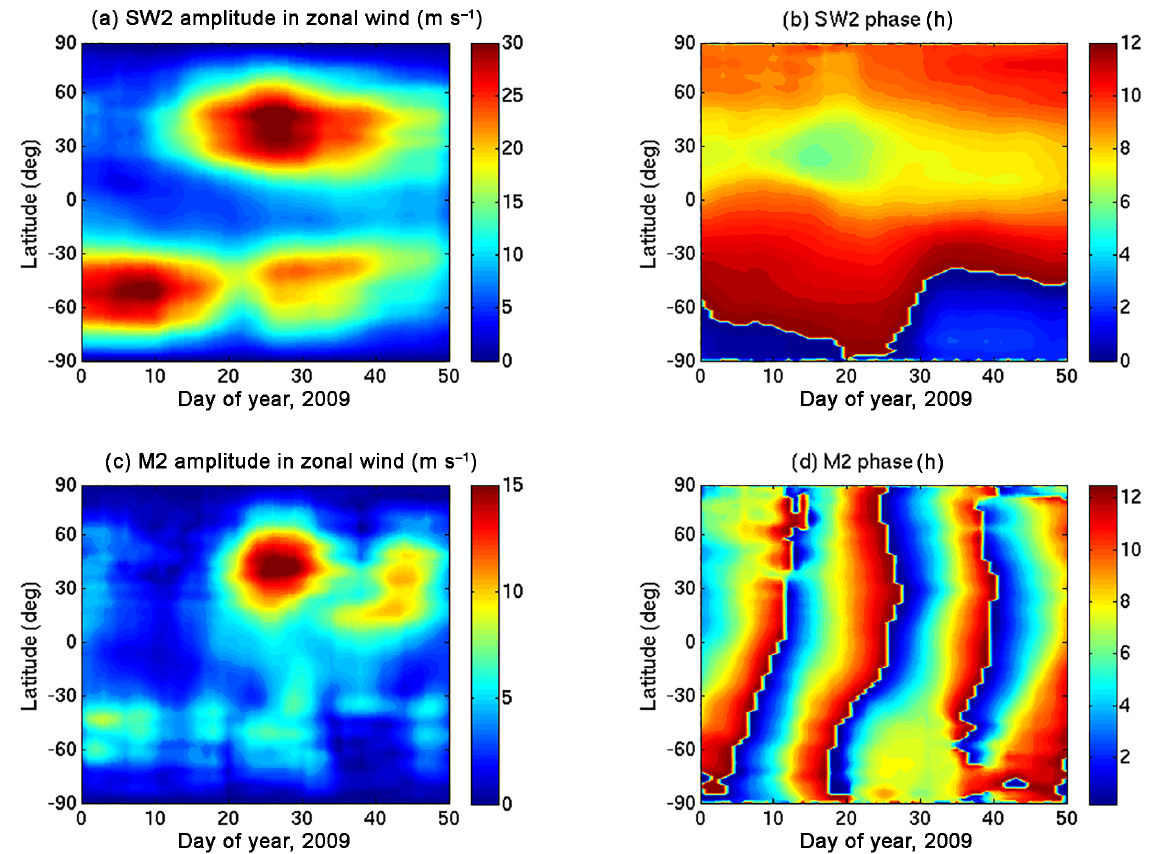
Figure 8. The amplitude (a) and phase (b) of the SW2 tide in zonal wind at ∼ 120km altitude during the 2008–2009 SSW event (simulations from Pedatella et al., 2018a). The amplitude and phase of the M2 tide during the same period are presented in (c) and (d) ,